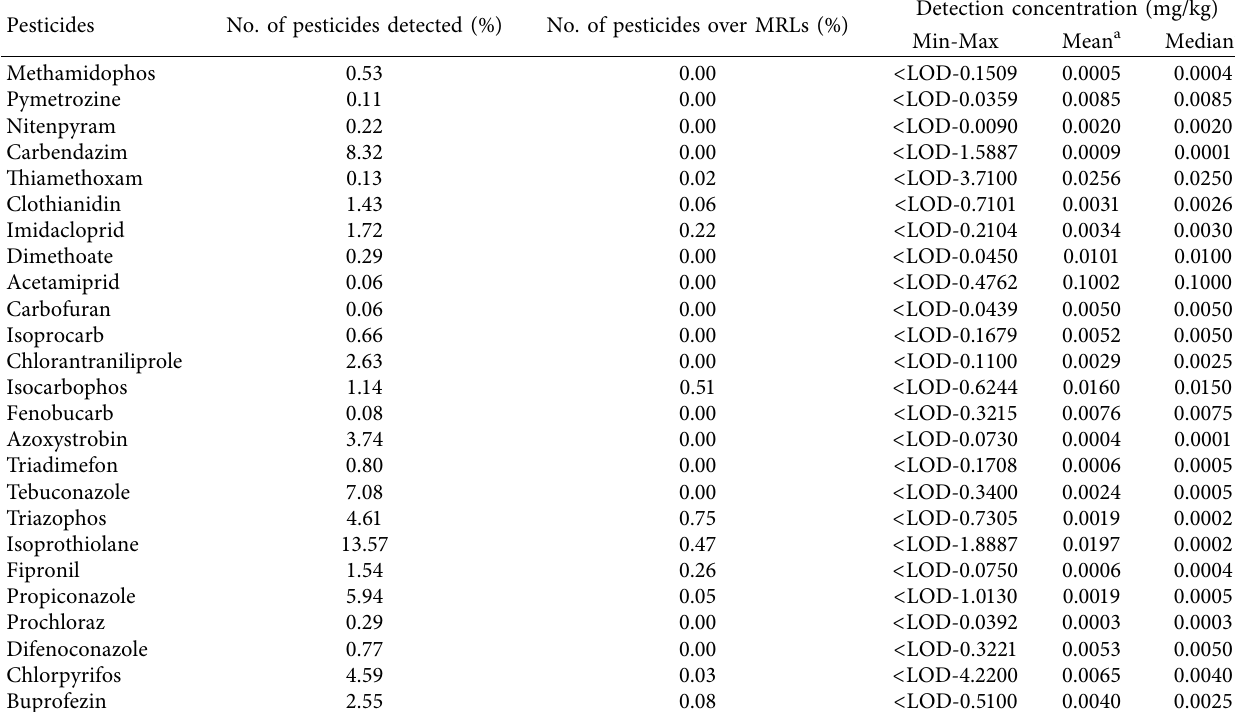
Table 4: The frequencies and concentration ranges of detected pesticide residues in brown rice from the three main rice-producing regions in China during 2016–2020. Pesticides